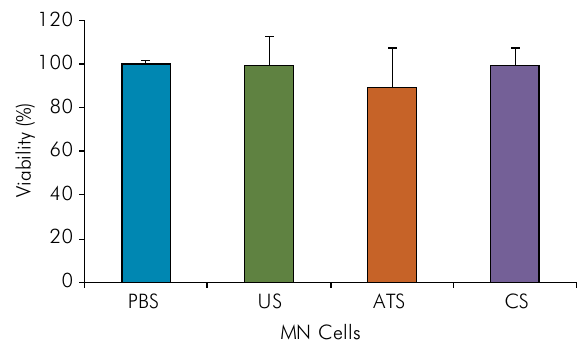
Figure 3. Viability index of human blood cells incubated with different materials. Cells, Cells on an acid-free surface (US), cells on an acid-treated surface (ATS) and cells on cement-treated surfaces (CS). The results are expressed as the mean and standard deviation of 6 replicates with human blood cells from different individuals. p > 0.05.